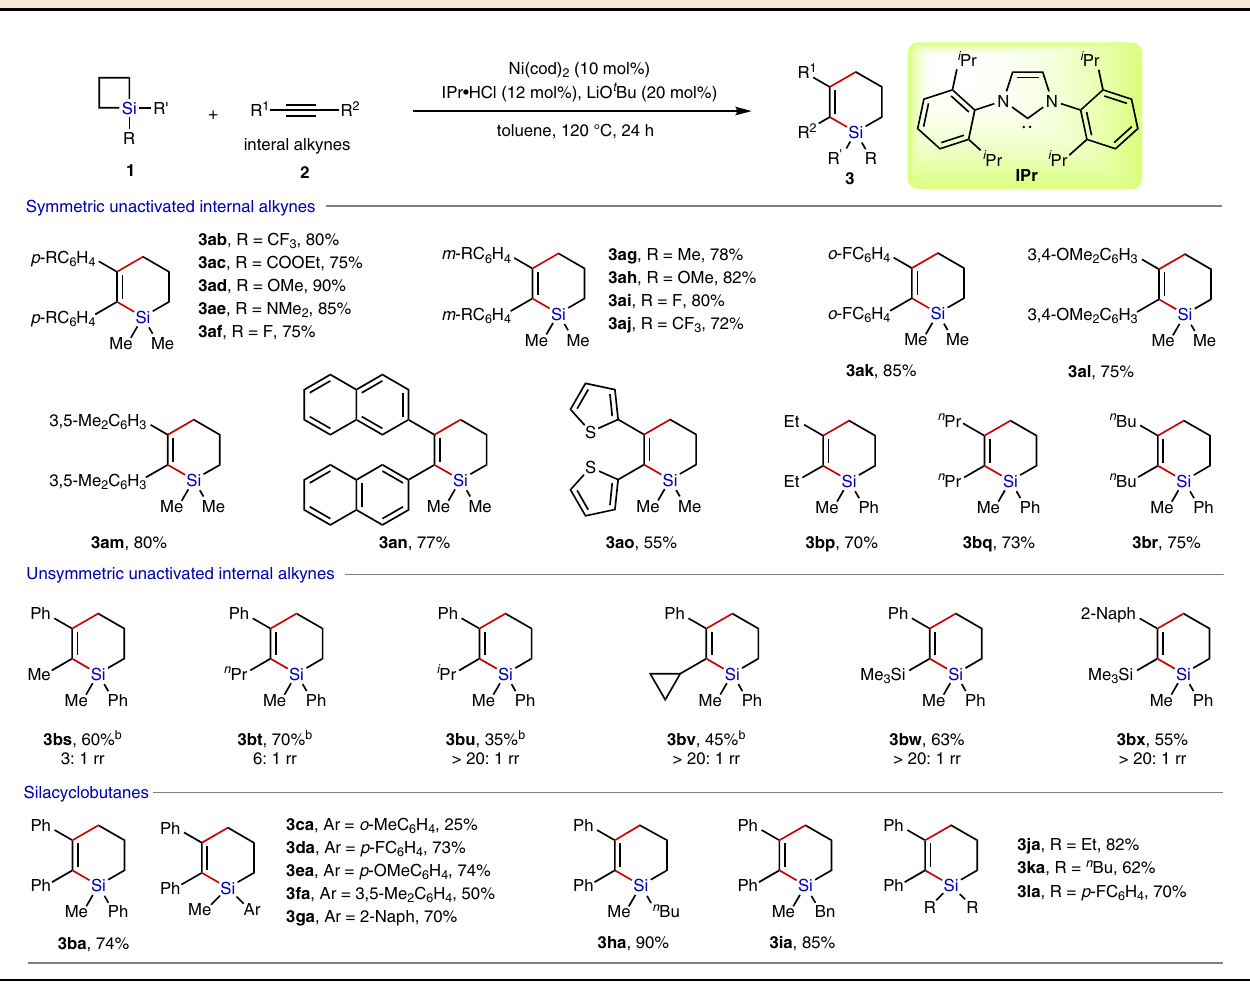
Table 2 Substrate scope for cycloaddition of SCBs with alkynes a